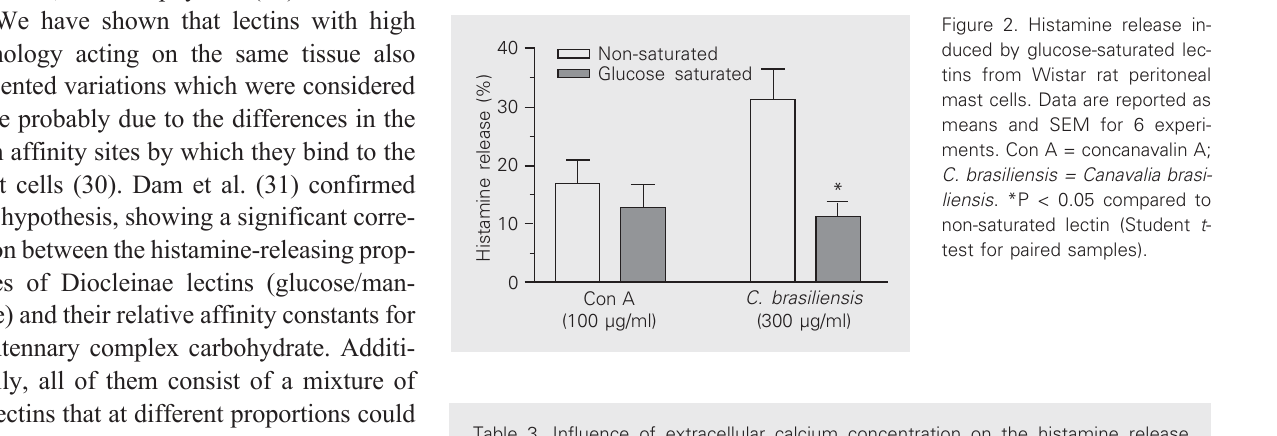
Table 3. Influence of extracellular calcium concentration on the histamine release induced by lectins from Wistar rat peritoneal mast